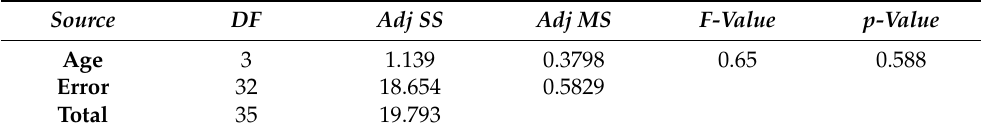
Table 11. Model summary of the ANOVA.